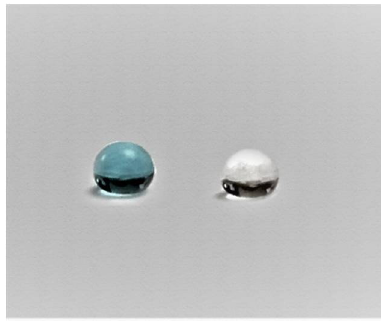
Figure 6. Images of dye and water droplets on PVDF membrane.